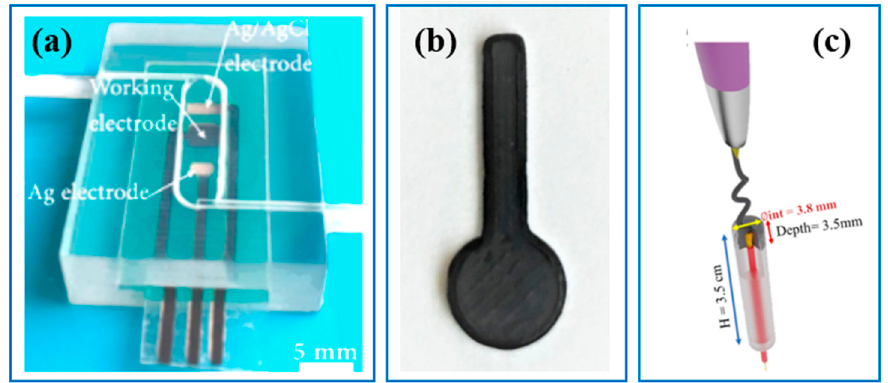
Figure 7. Three-dimensional-printed electrode for sensors. ( a ) Microfluidic with the device [17]; ( b ) Three-dimensional-printed electrode [52]; ( c ) Three-dimensional pen introducing conductive filament as the working electrode [54].